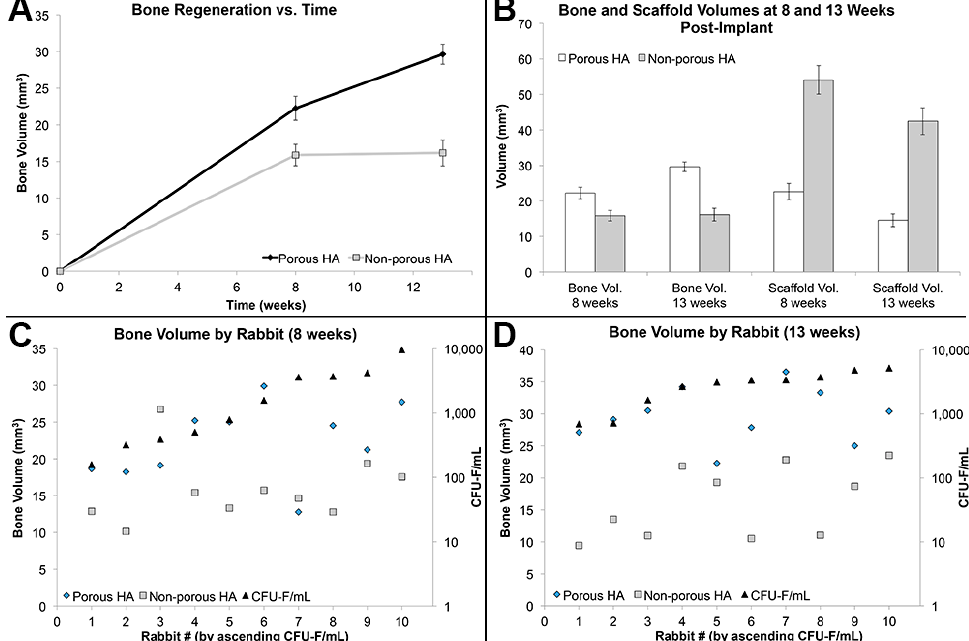
Figure 4. ( A ) Average bone regeneration versus time for porous (black) and non-porous (gray) hydroxyapatite (HA) granules through 13 weeks in vivo, with significant differences at both time points ( p < 0.01) and improvement with porous HA between 8 and 13 weeks ( p > 0.005); ( B ) new bone and remaining scaffold volume at 8 and 13 weeks for each material with significant decreases in residual scaffold for all scaffolds ( p < 0.05). New bone volume regenerated by porous and non-porous HA and corresponding colony forming units-fibroblast (CFU-F or MSC) concentration by rabbits at 8 ( C ) and 13 weeks ( D ) indicates improved function of non-porous scaffolds with increasing